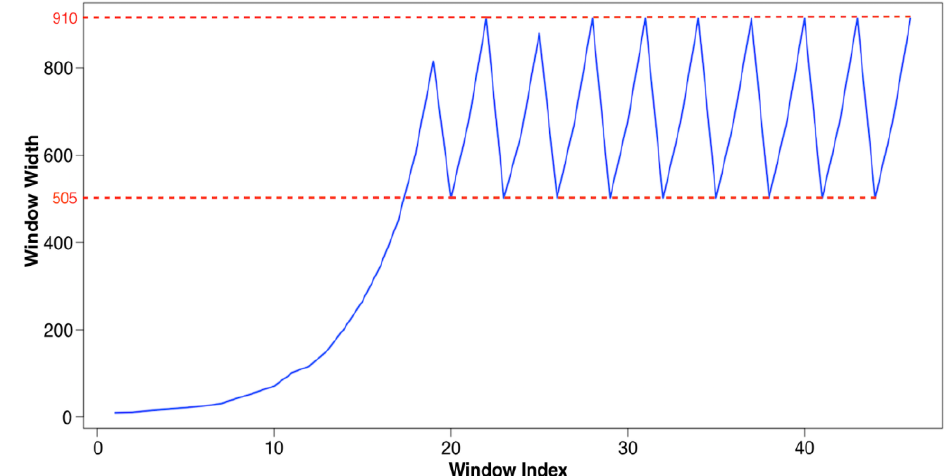
Figure 11. DW trajectory. Figure 11. DW